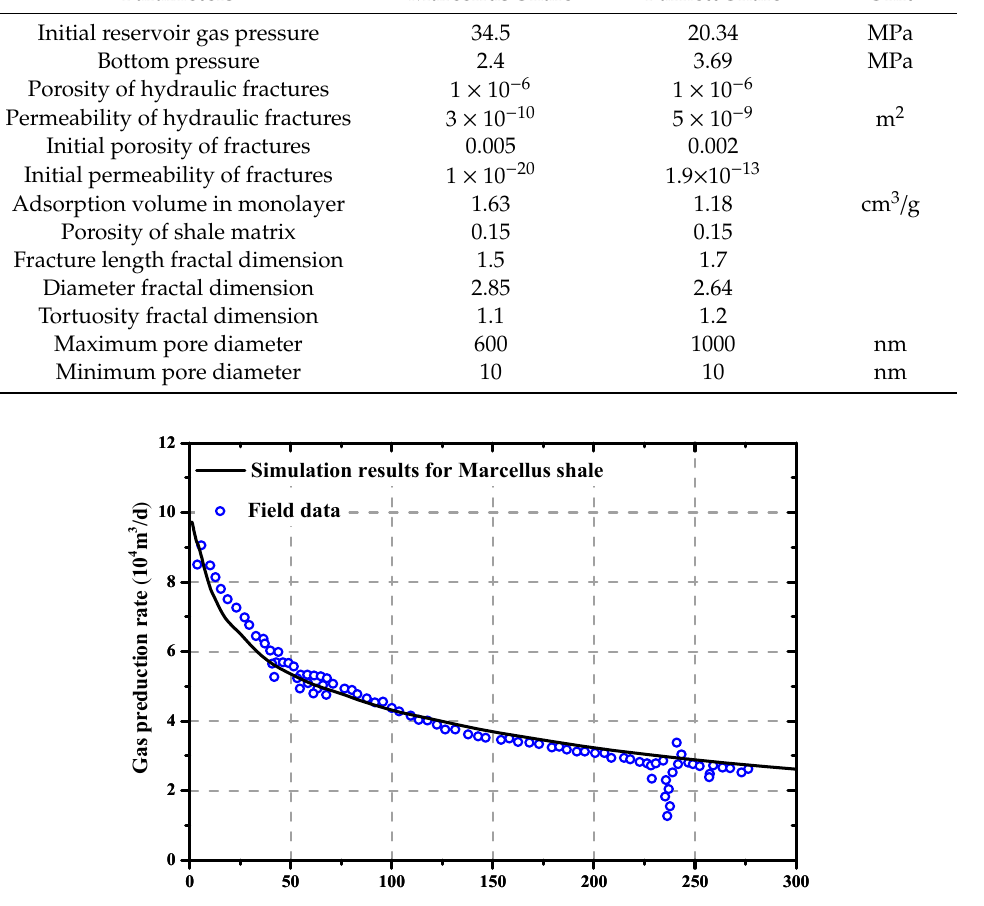
Figure 5. Comparison between our simulation results and the field data from the Marcellus shale well.